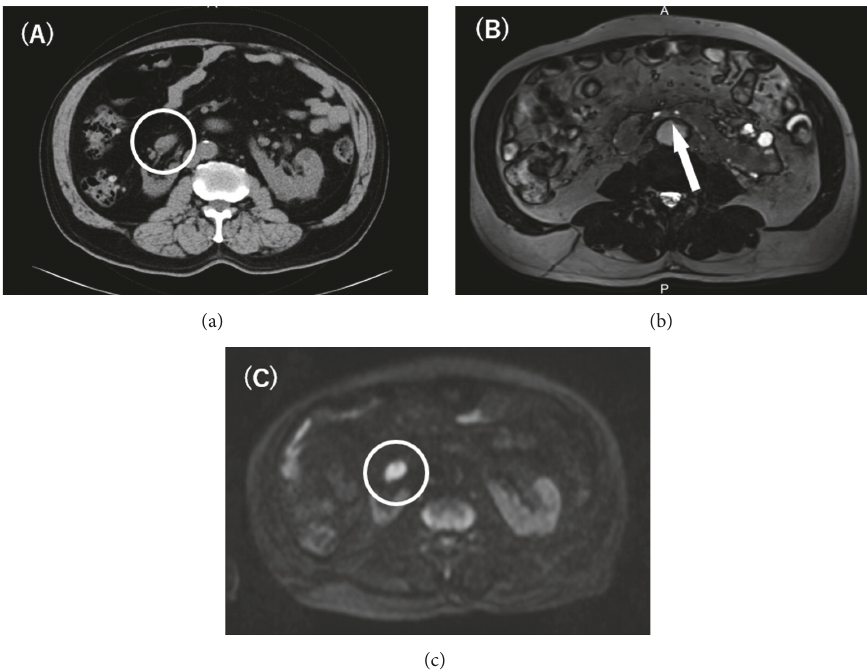
Figure 1: (a) CT scan axial image. A 28 mm tumor is shown in the right renal pelvis. (b) T2-weighted MR image. Arrow indicates the isthmus of a horseshoe kidney. (c) Diffusion-weighted MR image. The tumor in the right renal pelvis shows high